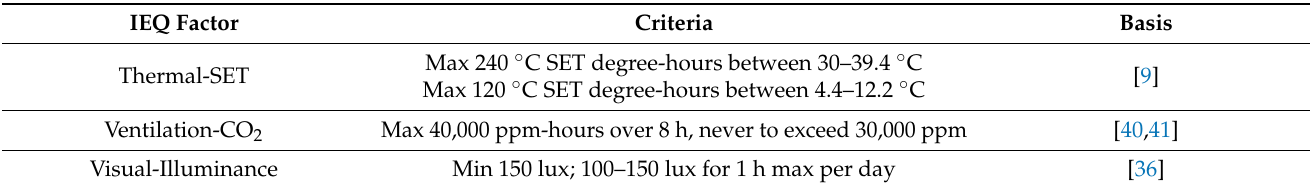
Table 1. Criteria for calculating OHL based on standard effective temperature, CO 2 , and illuminance.